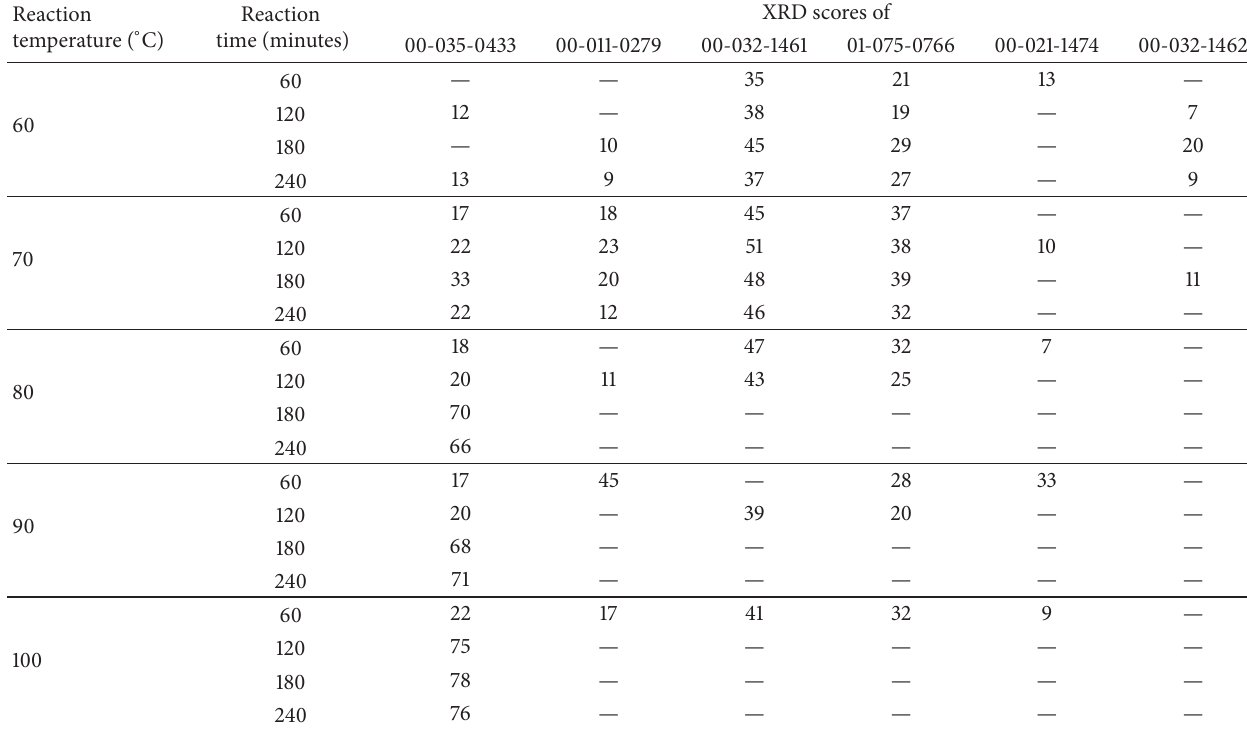
Table 3: XRD results of the synthesised zinc borates.